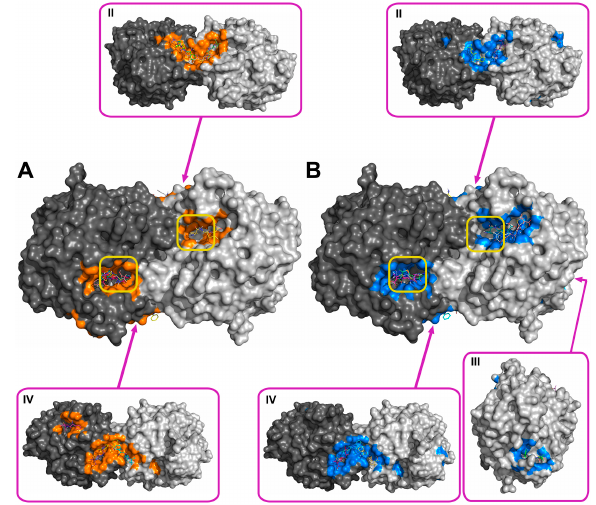
Figure 2. Supposed localization of the domains for binding ampicillin at pH 7.5 ( A ) and 10.5 ( B ). The two subunits of the His 6 ‐ OPH homodimer are colored differently (grey and dark grey). Atoms on the surface of His 6 ‐ OPH located within 4 Å of any atom of ampicillin, as well as the corresponding molecular surface, are colored orange ( A ) or marine ( B ). Entrances to the active sites of the His 6 ‐ OPH dimer are highlighted with yellow boxes. Magenta boxes show clockwise a His 6 ‐ OPH dimer molecule when viewed from above (II), from the right (III), and from below (IV) (relative to the side where the active sites are located).